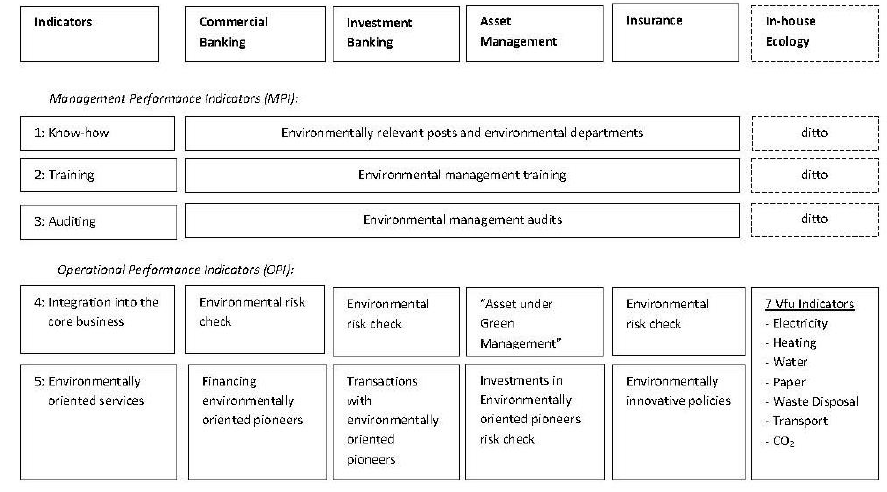
FIGURE 2: Overview of Environmental Performance Indicators for the Financial Industry Source: Schmid-Schonbein and Braunschweig